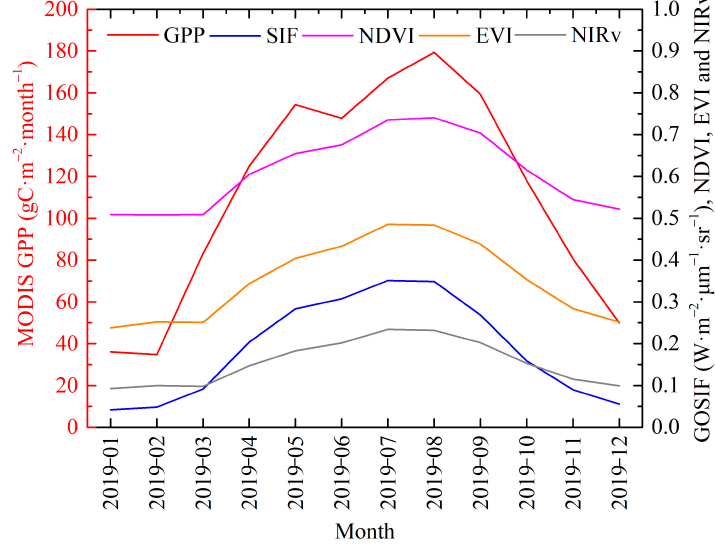
Figure 15. Monthly variations of MODIS GPP, GOSIF, NDVI, EVI, and NIRv in 2019.